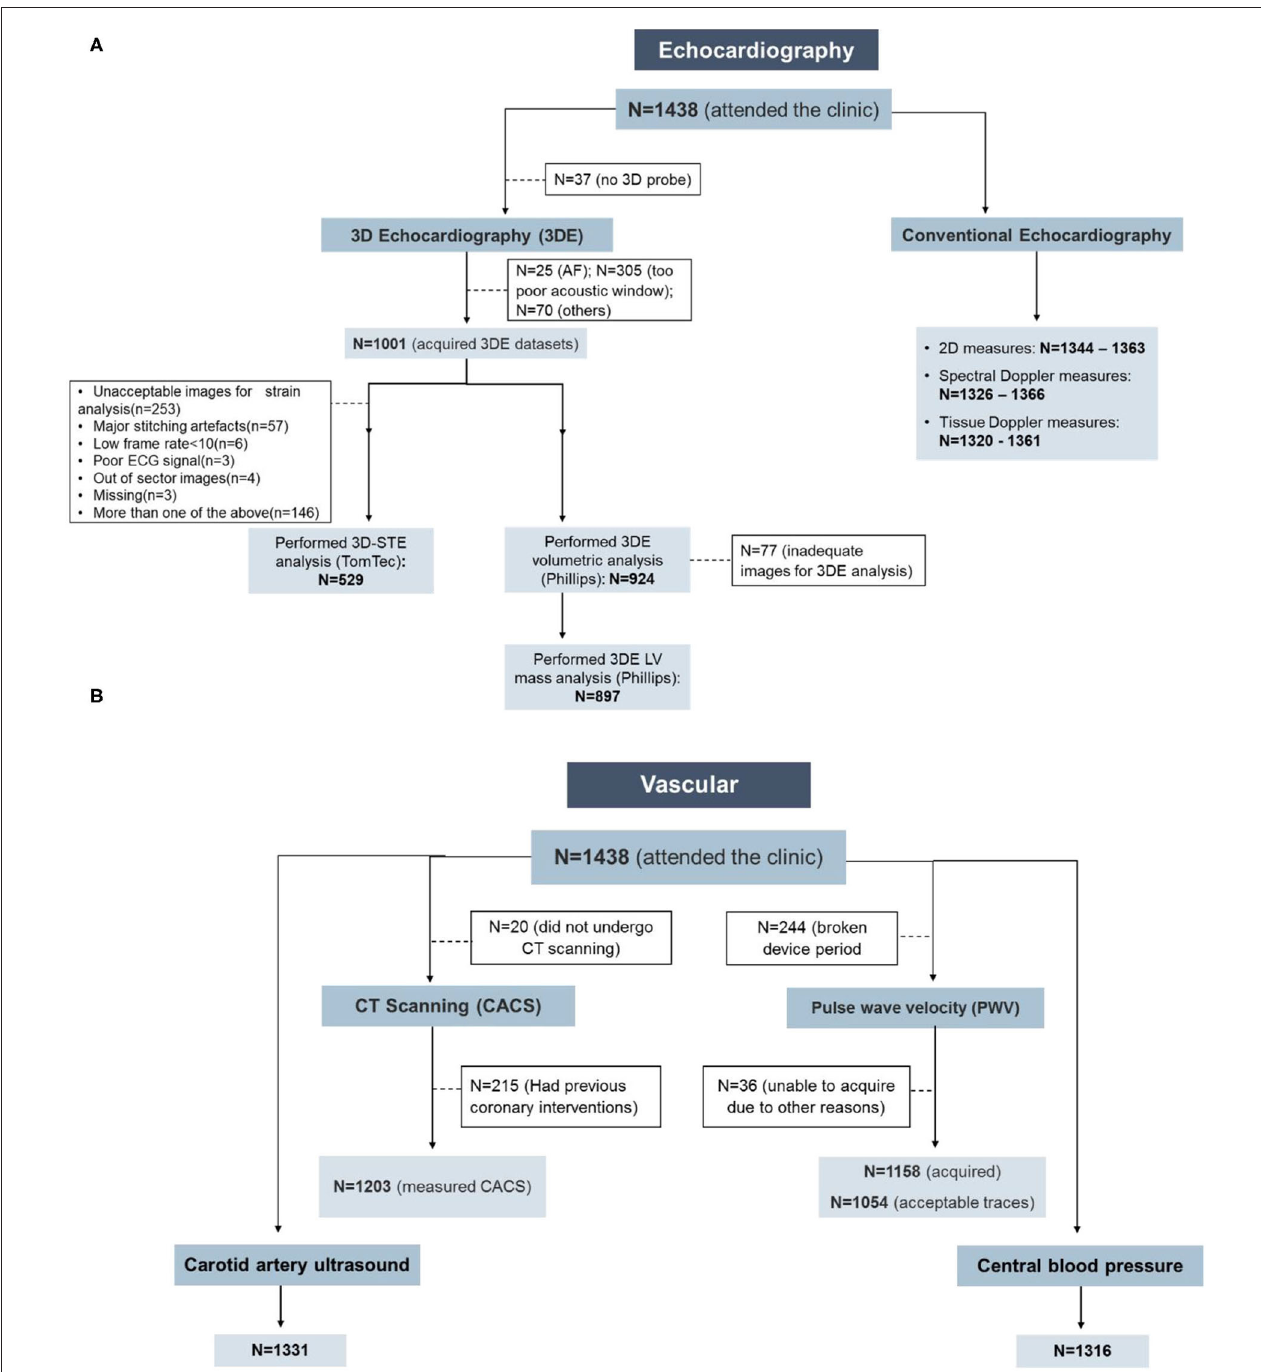
FIGURE 1 | Feasibility of the cardiovascular measurements in the Southall and Brent Revisited (SABRE) study. (A) Echocardiography and (B) vascular measurements. AF, atrial fibrillation; CACS, coronary artery calcium score; CT, computed tomography.